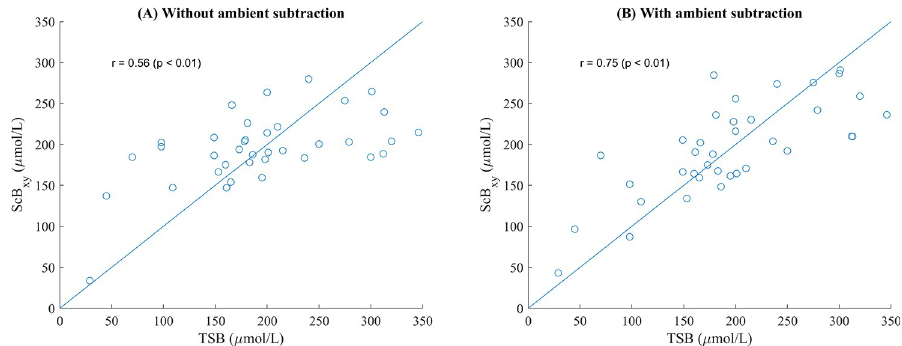
Fig 4. Scatter plot of scleral-conjunctival bilirubin (SCB) against TSB with and without ambient subtraction, 37 subjects. The use of ambient subtraction greatly improves the correlation. (A) Correlation without ambient subtraction, r = 0.56. (B) Correlation with ambient subtraction, r = 0.75.